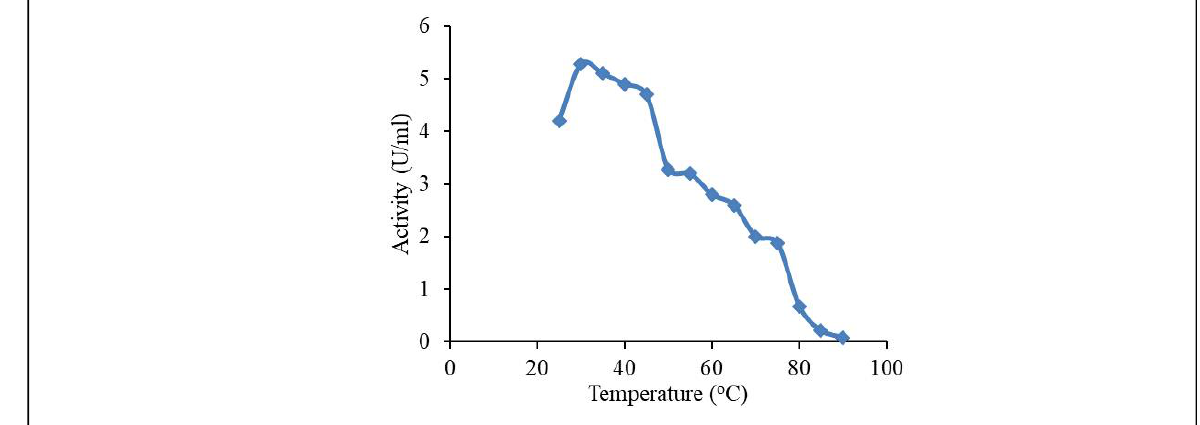
Figure 2: Effect of temperature on peroxidase activity (fraction